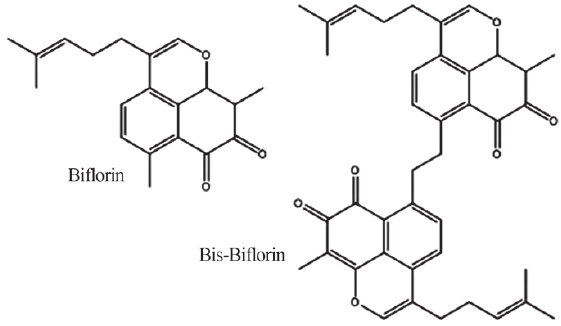
Figure 3 - Chemical structures of biflorin and bis-biflorin (Fonseca et al. 2003).